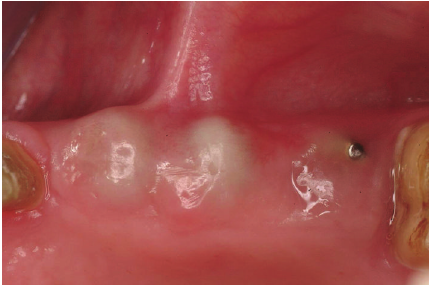
Figure 23: Radiographic postoperative control: coincidence of radiopaque landmarks embedded in the temporary crowns and the implant position of 24, 25, and 26.